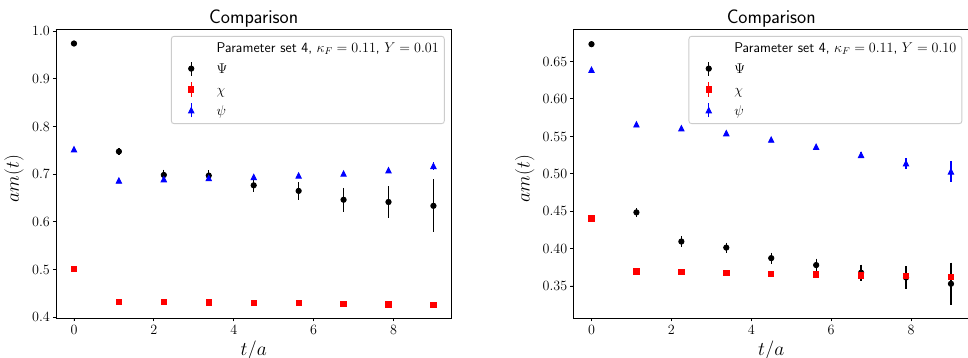
Figure 4: The effective mass of the bound state operator Ψ compared to the effective masses of the elementary fermions ψ and χ at small Yukawa couplings (top panel) and large Yukawa couplings (bottom panel) for parameter set 4 at κ